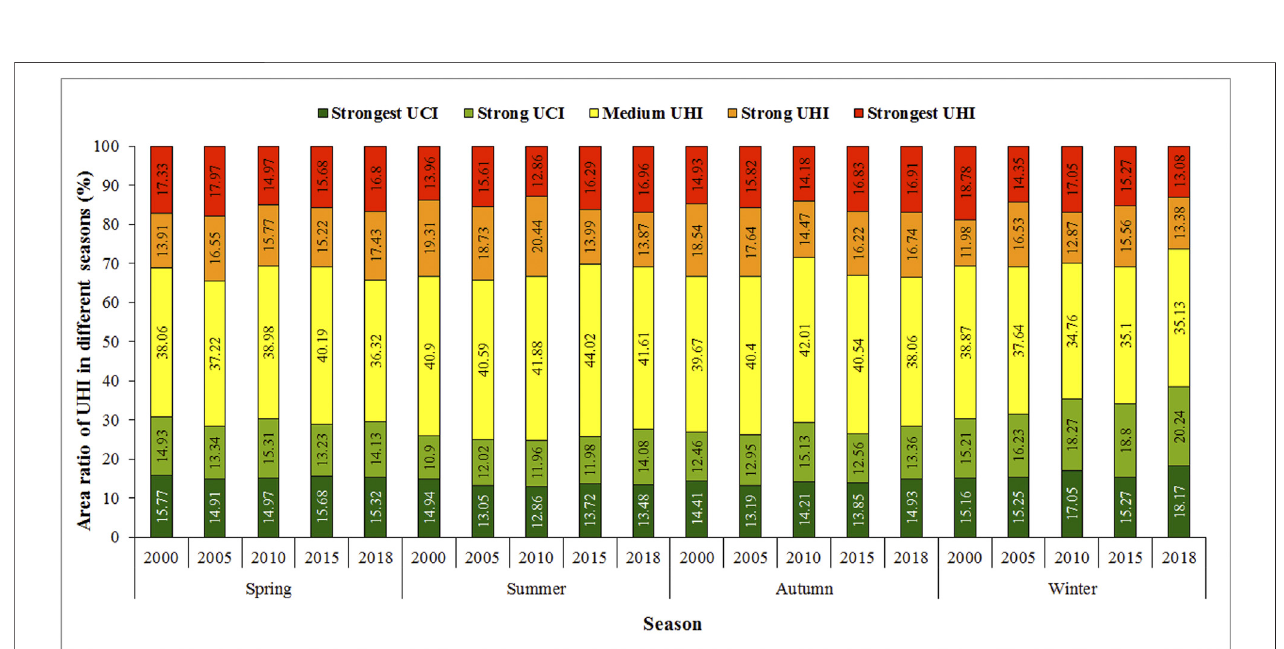
FIGURE 6 | Area ratio of the UHI effect for the spring, summer, autumn, and winter seasons during the period 2000 – 2018.